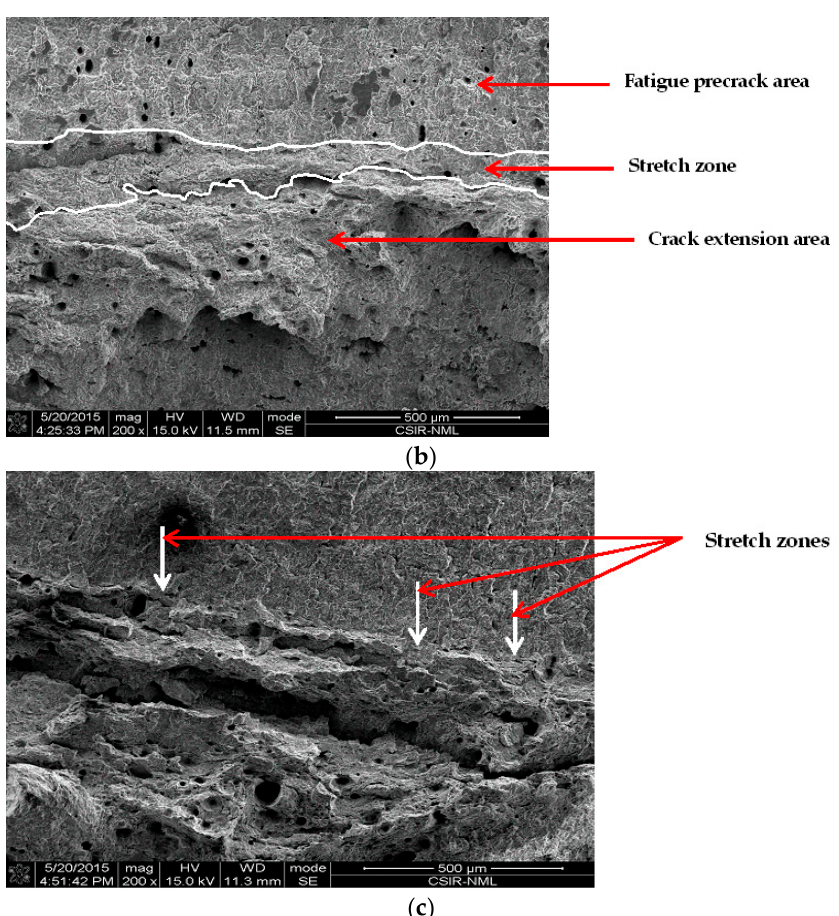
Figure 13. SEM fractograph of J -integral tested MAS in E80 with ( a ) 0 mg/L; ( b ) 32 mg/L; and ( c ) 64 mg/L NaCl, showing decreasing stretch zone (SZ) and void coalescence ahead of fatigue pre-crack with increasing chloride.